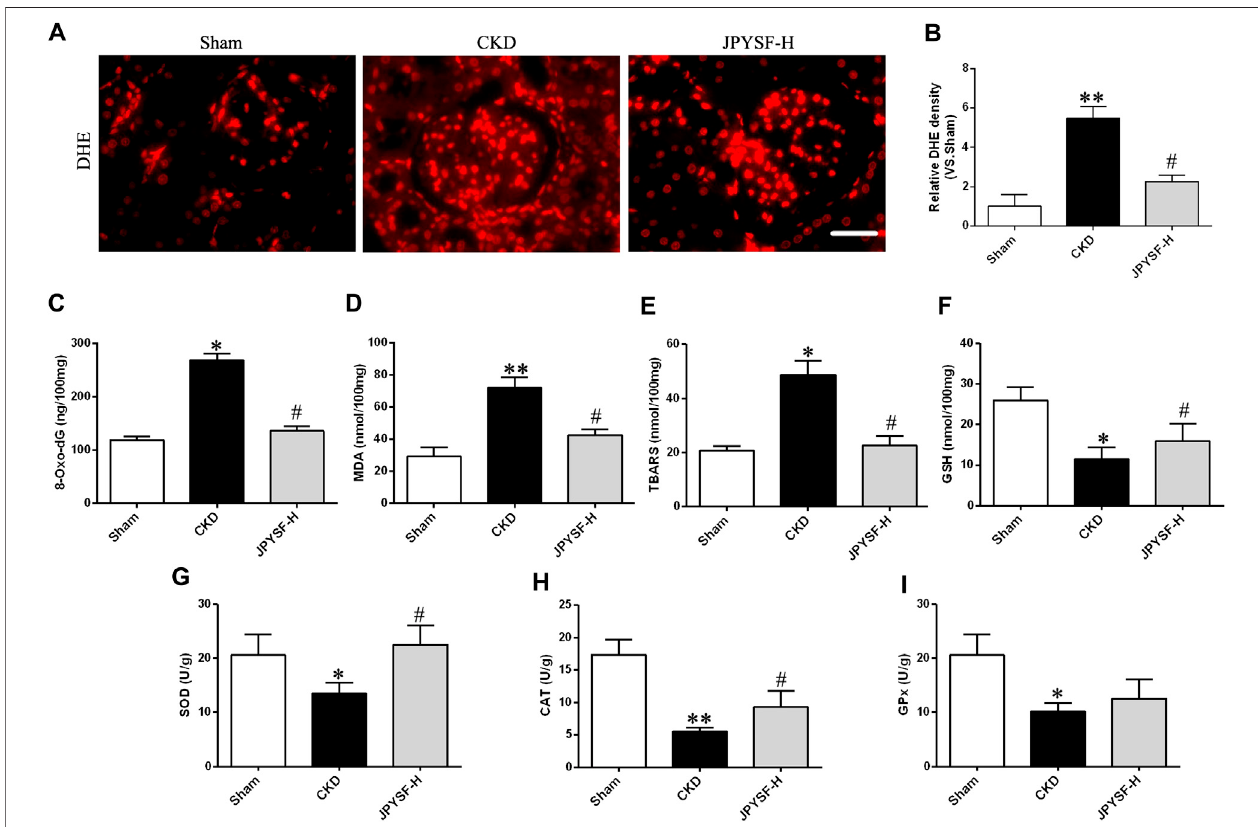
FIGURE 4 | JPYS formula suppresses oxidative stress in the kidneys from CKD rats. (A) Immuno fl uorescence staining for dihydroethidium (DHE) in the kidney ( × 400,scalebar (cid:2) 50 μ m). (B) Quanti fi cationofDHEintensity.Relativeexpressionlevelsof8-oxo-dG (C) ,MDA (D) ,TBARS (E) ,GSH (F) ,SOD (G) ,CAT (H), andGPx (I) . All data are expressed as means ± SEM. * p < 0.05, ** p < 0.01 vs. the sham group; # p < 0.05 vs. CKD